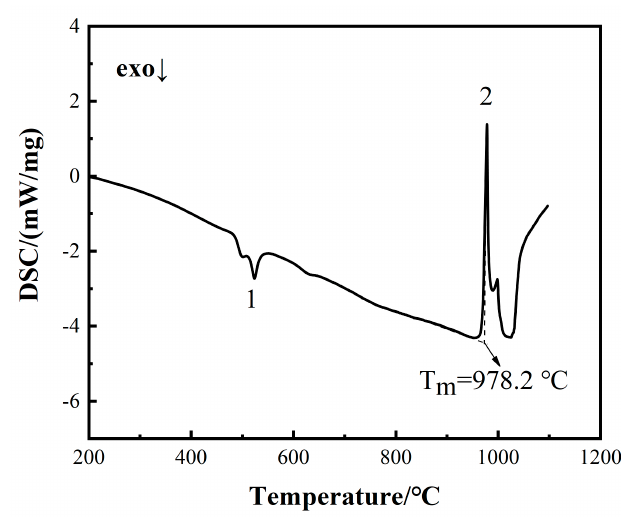
Figure 3. DSC curve of the BNi2 filler metal.